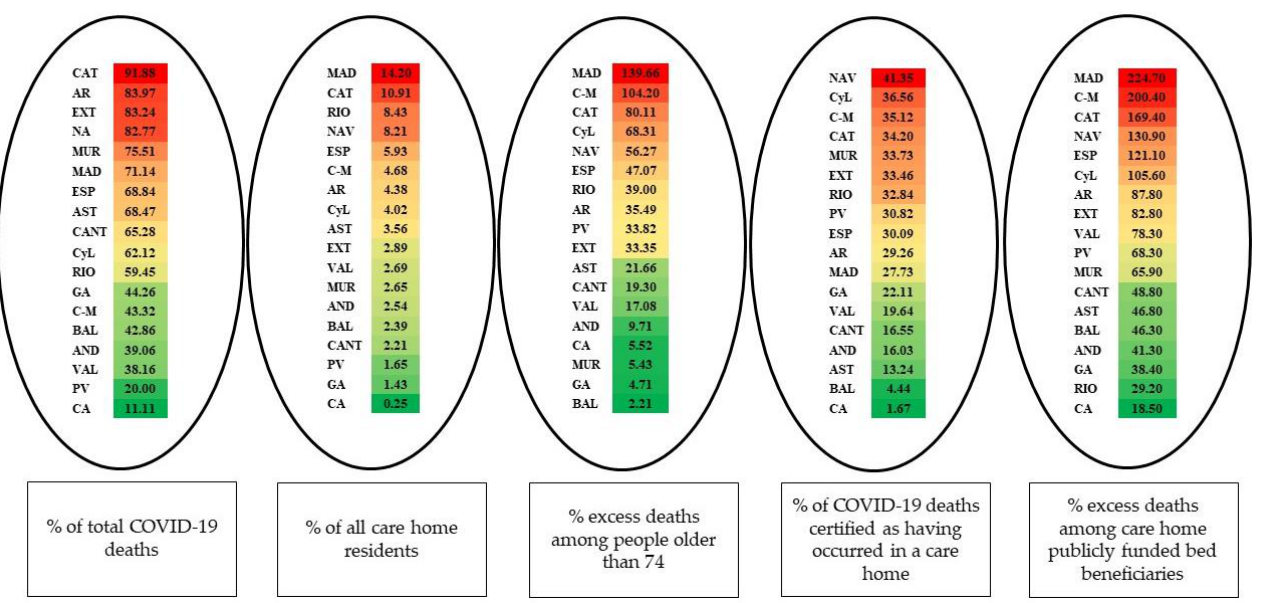
Figure 1. Autonomous Communities ranked by care home COVID-19 mortality indicators. Source: